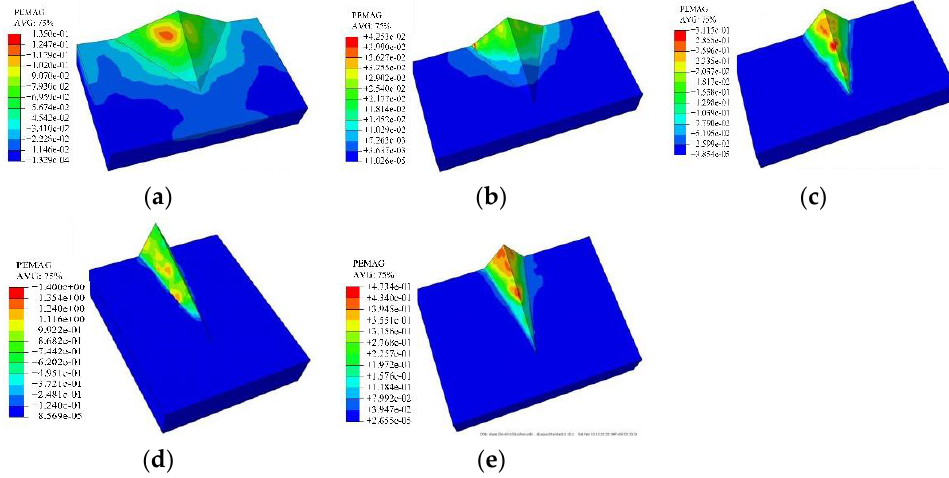
Figure 9. Plastic zone cloud map of ridge slope under different flank dip angles; (a) β =30°; (b) β =40°; (c) β =50°; (d) β =60°; (e) β =70°.